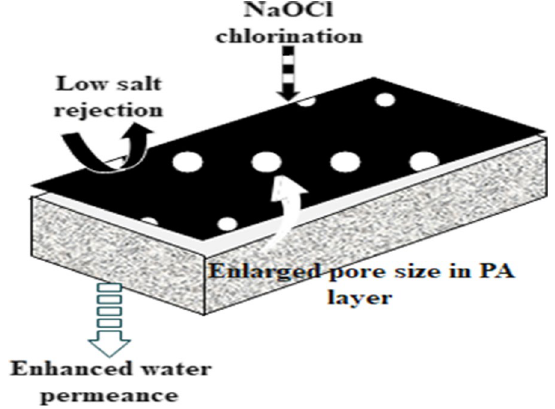
Fig. 1 Mechanism of transport through reverse osmosis membrane modified by